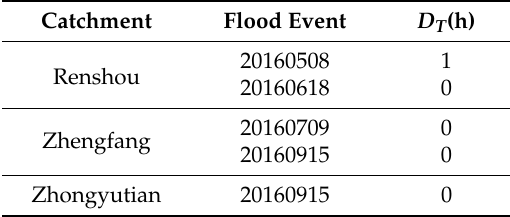
Table 8. Model verification performance using reservoir water stage data.